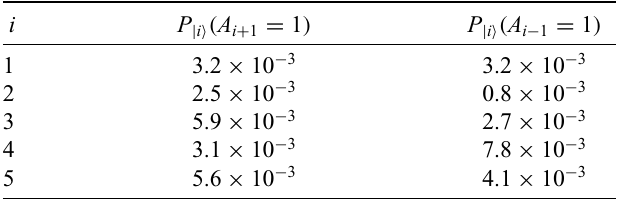
TABLE II. The experimentally measured orthogonality rela- tionship of the compatible measurements. By the definition in Eq. (19) of the main text, the conditions (cid:6) i | i + 1 (cid:2) = 0 and (cid:6)